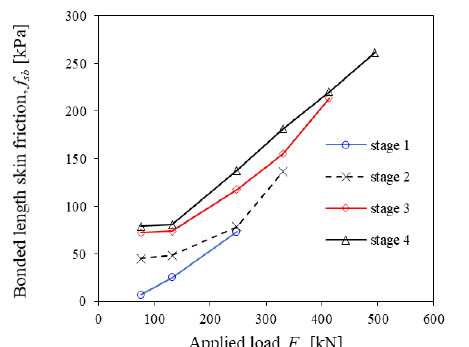
Figure 17 - Skin friction calculated between instrumented sections SG1 and SG2 of anchor T33 as a function of the applied load F a